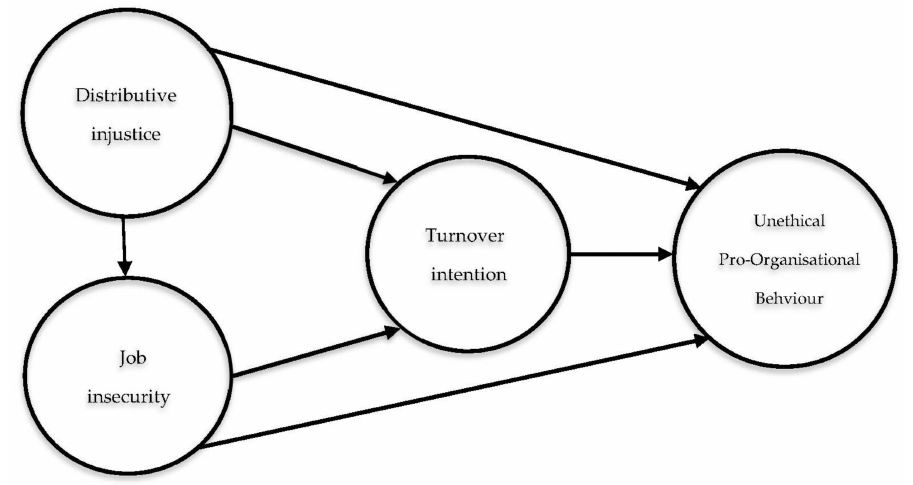
Figure 1. The Research Conceptual